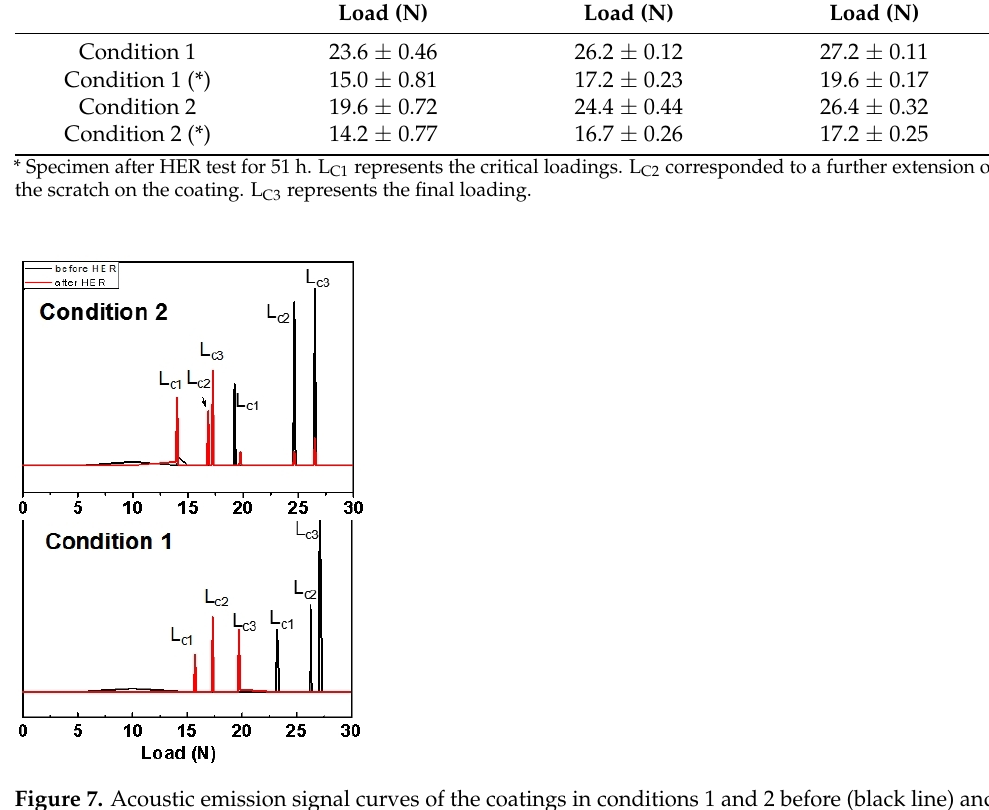
Figure 7. Acoustic emission signal curves of the coatings in conditions 1 and 2 before (black line) and after (red line) the HER test for 51 h.